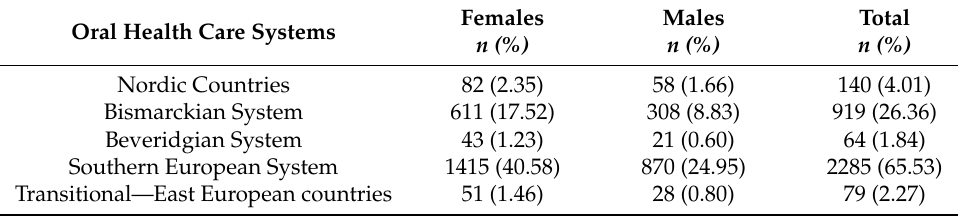
Table 1. Distribution of the sample by oral health care systems.